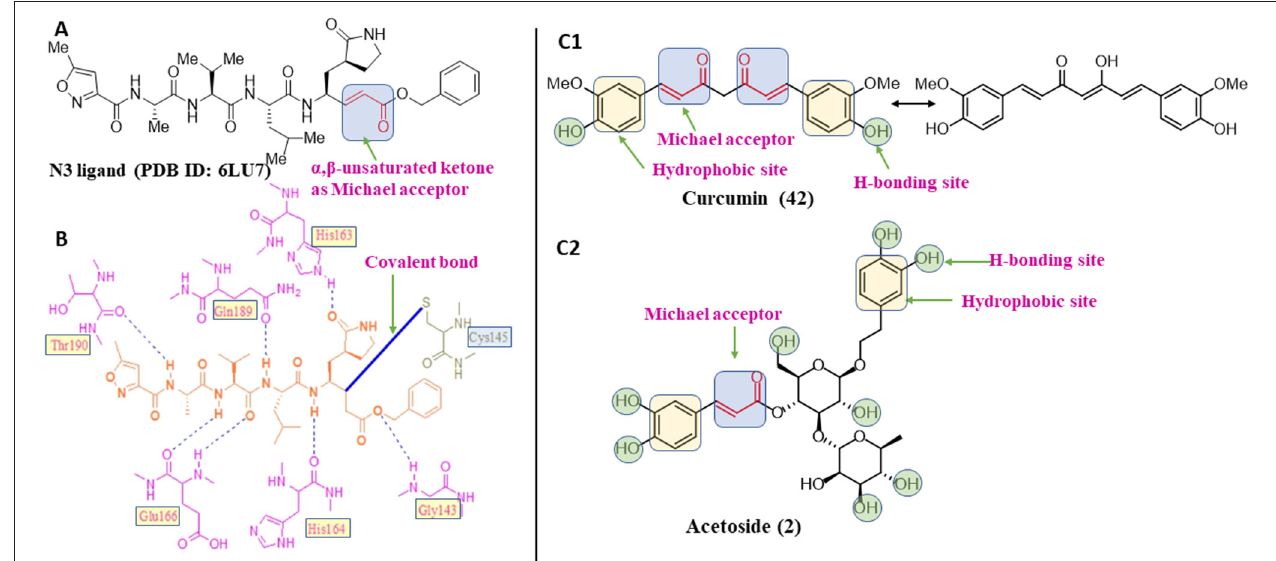
FIGURE 5 | Structural characteristics of N3 ligand of SAR-CoV-2 Mpro (PDB ID: 6LU7). (A) Important structural feature offered by N3 ligand as covalent inhibitor. (B) 2D-interaction diagram of ligand N3 and Mpro, dark blue colored solid line depicted covalent bond ( Jin et al., 2020); (C1) Important structural features offered by the curcumin as covalent inhibitor; (C2) Important structural features of acetoside as covalent inhibitor.